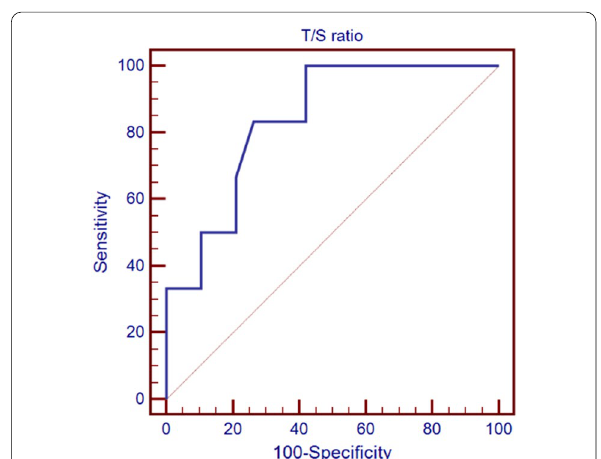
Fig. 7 ROC curve of TSR as a predictor of Her2 molecular subtype